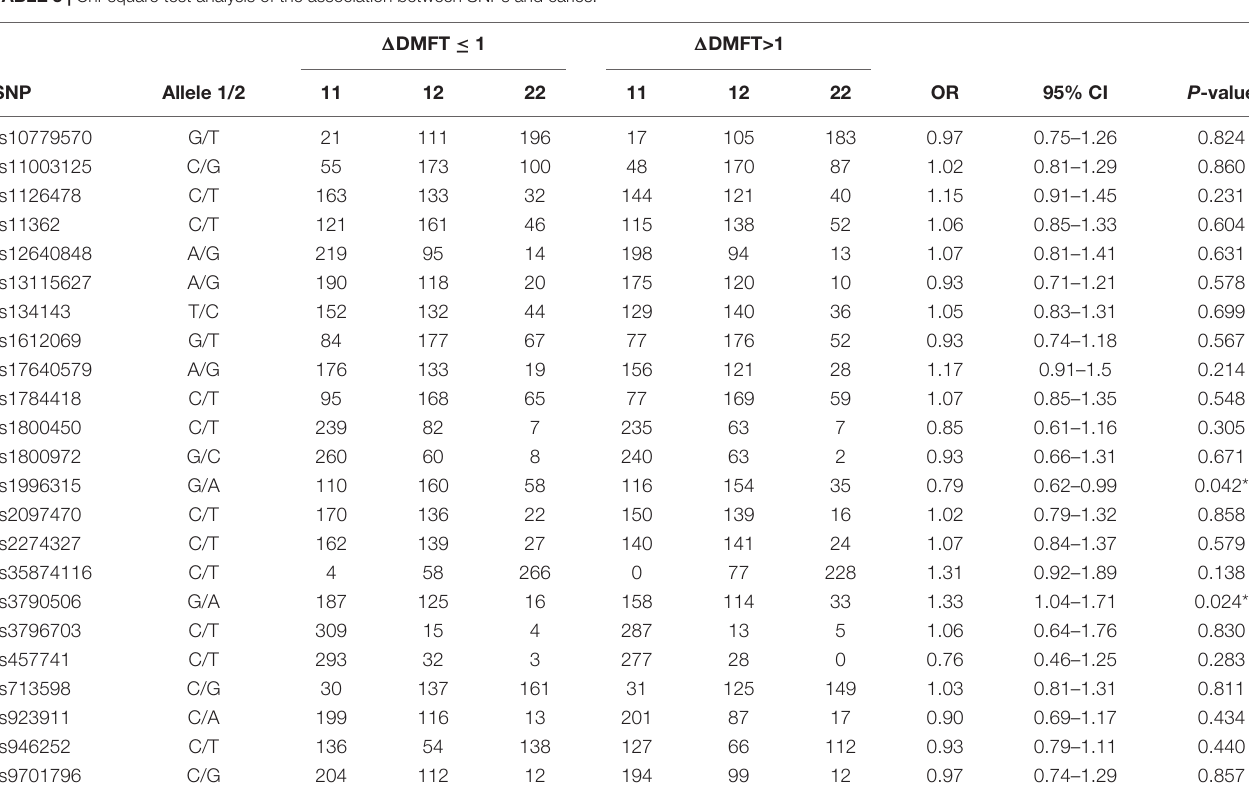
TABLE 3 | Chi-square test analysis of the association between SNPs and